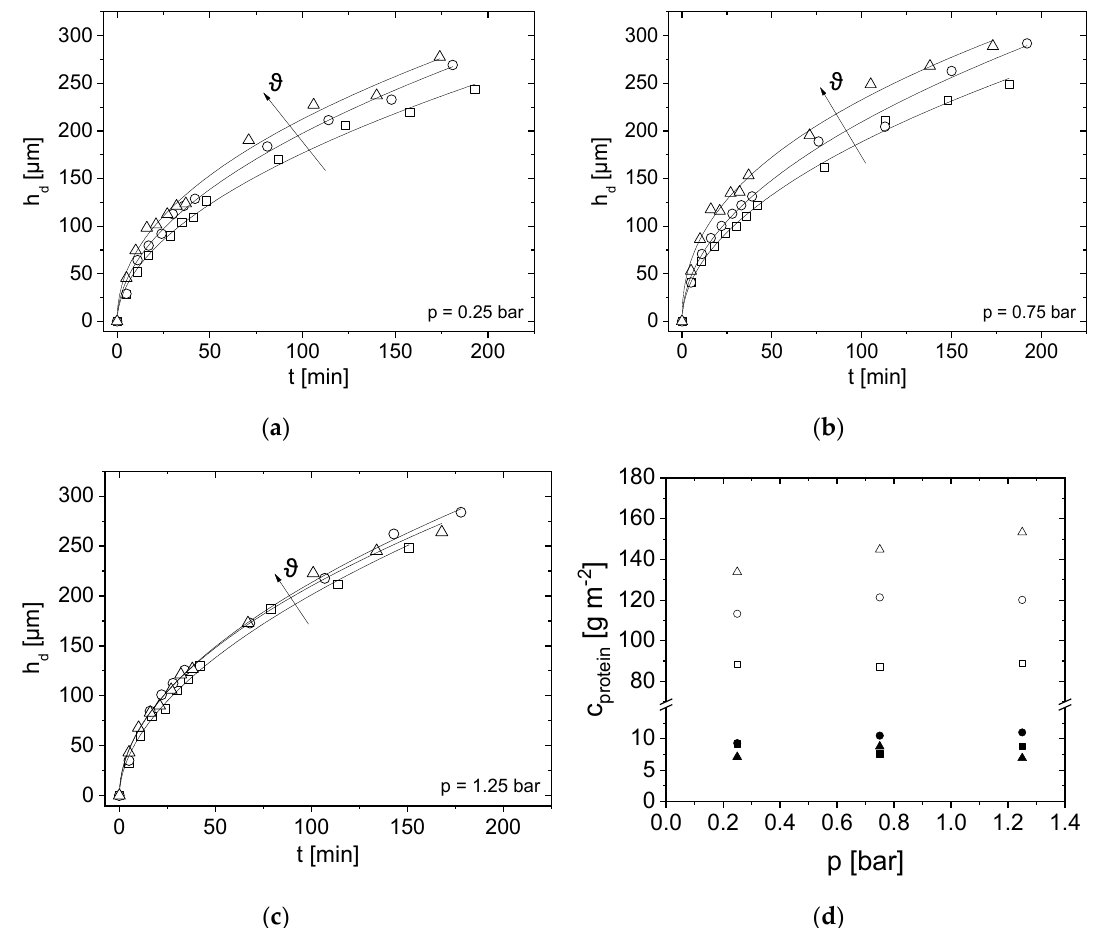
Figure 7. h d at z = 29 cm as a function of filtration time t at ( a ) p = 0.25 bar ( b ) p = 0.75 bar and ( c ) p = 1.25 bar. Temperature was set to ϑ = 15 °C (squares), ϑ = 22 °C (circles) and ϑ = 45 °C (triangles). ( d ) Protein concentration c protein for caseins and whey proteins on membrane surface as a function of the pressure p for the three temperatures for p = 0.25 bar (squares), p = 0.75 bar (circles) and p = 1.25 bar (triangles). Open symbols are casein and closed are whey proteins.